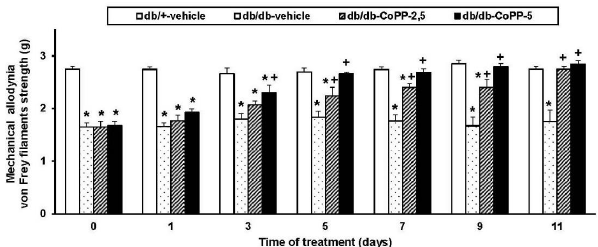
Figure 1. The inhibition of mechanical allodynia induced by CoPP in db/db mice. Mechanical allodynia in the hind paws of db/db mice intraperitoneally treated with vehicle or CoPP (2.5 and 5 mg/kg) during 11 consecutive days is shown. The effects of vehicle in db/+ mice are also represented. Data are shown at day 0, 1, 3, 5, 7, 9 and 11 of CoPP treatment and expressed as von Frey filaments strength (g). For each day evaluated, * indicates significant differences vs. db/+ mice treated with vehicle and + indicates significant differences vs. db/db mice treated with vehicle ( p < 0.05, one-way ANOVA followed by the Student Newman Keuls test). Each column represents the mean and vertical bars indicate the standard error of the mean (SEM); n = 6 animals for each group.